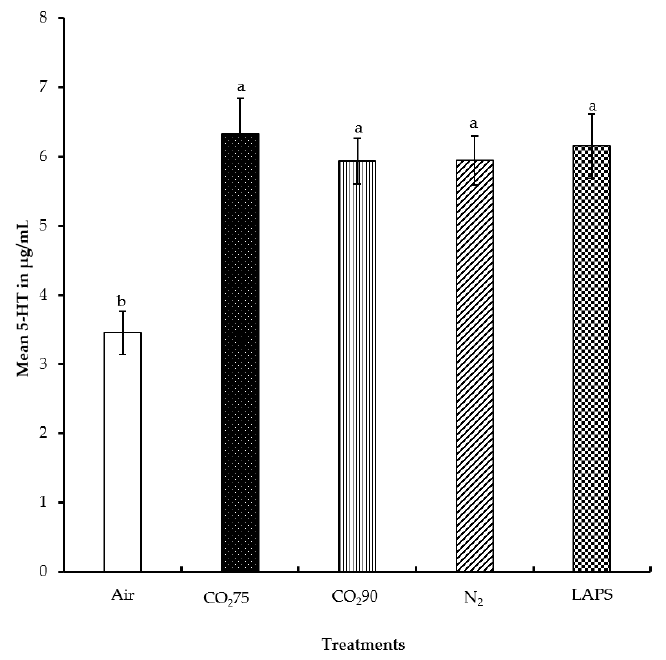
Figure 5. Mean serum serotonin levels of male layer chicks. The 5-HT concentrations were measured in duplicate and expressed in µg/mL. Bars (mean ± SEM) with different superscripts are significantly different by Fisher’s LSD test ( p < 0.05). Number of samples per treatment was